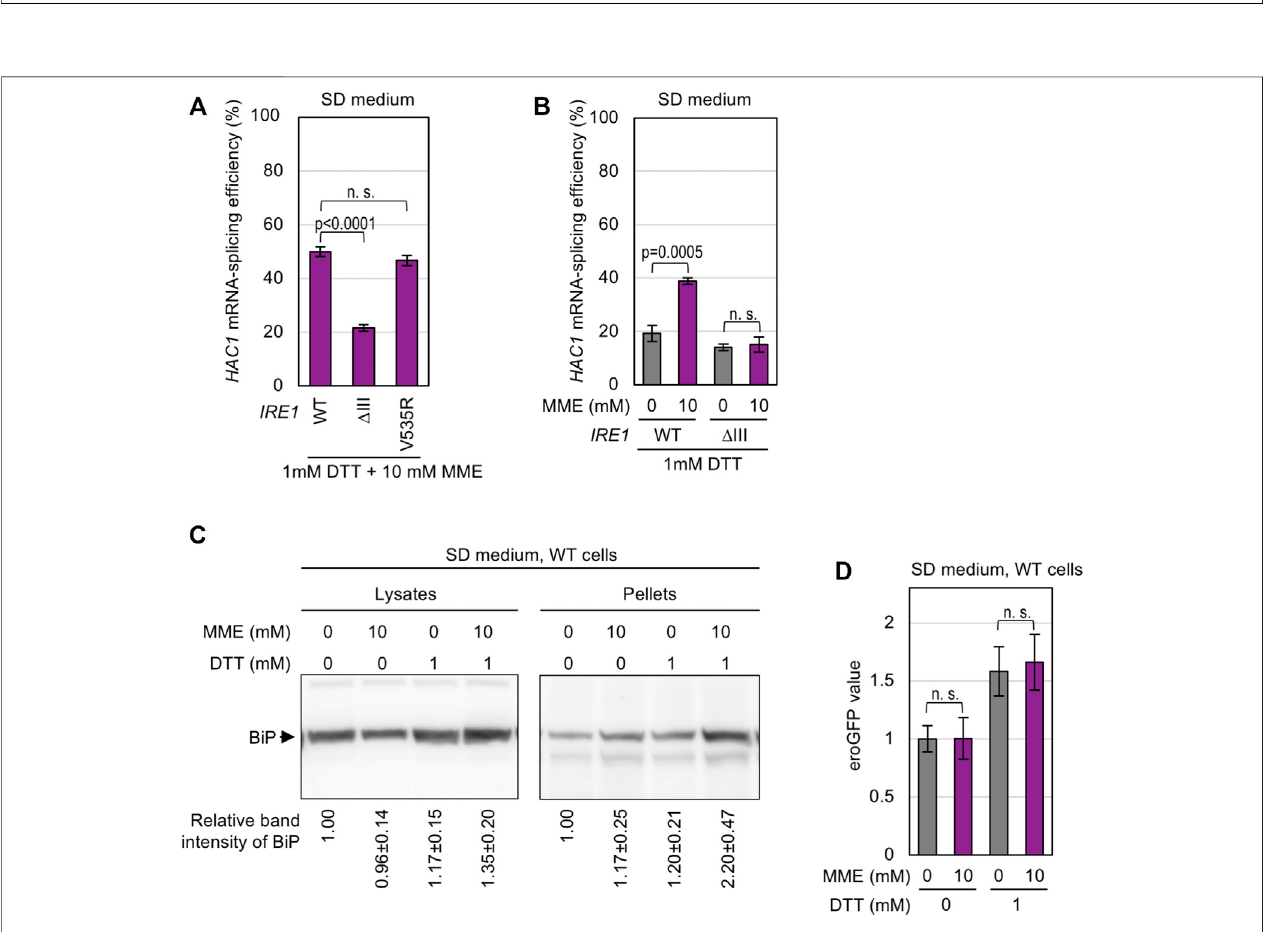
FIGURE 4 | Aggravation of DTT-induced aggregation of ER proteins by PMME. (A,B) The KMY1516 strain ( ire1 Δ ) carrying the IRE1 plasmid pRS313-IRE1 (wild- type (WT) or the indicated mutants) was grown in SD medium and treated with 10 mM PMME and/or 1 mM DTT or not treated as shown in Figure 2C . The cells were then checkedfor HAC1 -mRNA splicing. (C) Wild-type yeastBY4741cells(WTcells) weregrowninSDmedium andtreatedwith10 mMPMMEand/or 1 mMDTTornot treated as shown in Figure 2C . The cells were then subjected to the BiP sedimentation assay. The panels represent anti-BiP Western-blotting images of the total cell lysates (equivalent to 0.025 OD 600 cells) and the pellet samples(equivalent to 0.25 OD 600 cells). (D) BY4741 cells (WT cells) carryingthe eroGFP expression plasmid pPM28 were grown in SD medium and treated with 10 mM PMME and/or 1 mM DTT or not treated as shown in Figure 2C . The cells were then observed under a fl uorescence microscope. The eroGFP values are normalized against that of non-treated cells, which is set at 1.00. ns, not signi fi cant ( p > 0.05).